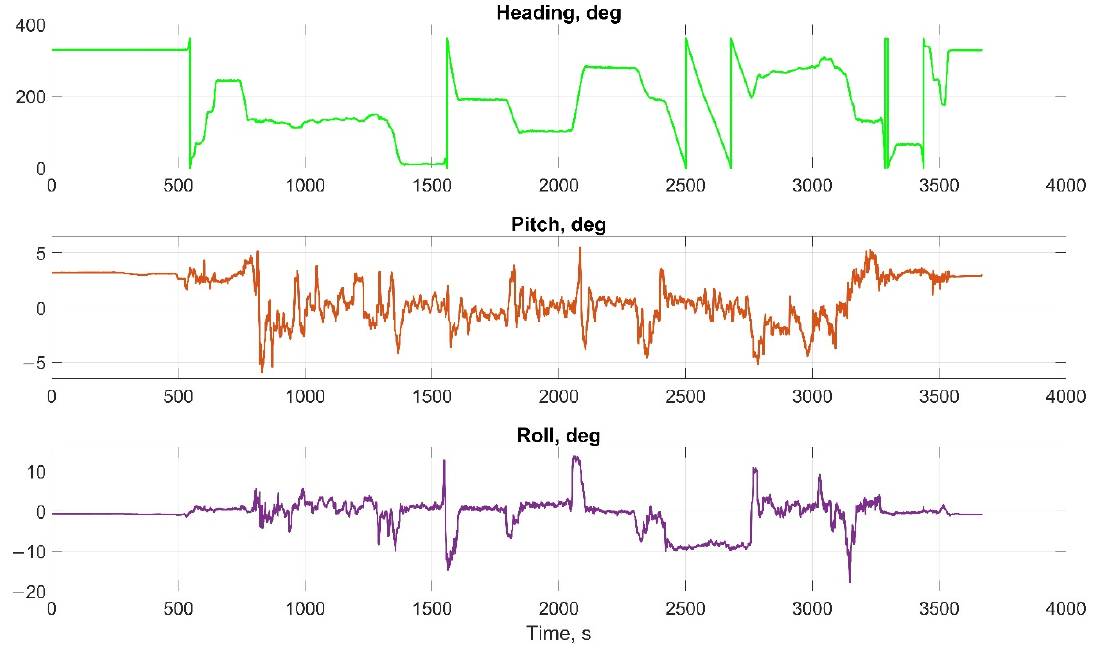
Figure 15. Reference values of the attitude angles in helicopter test.